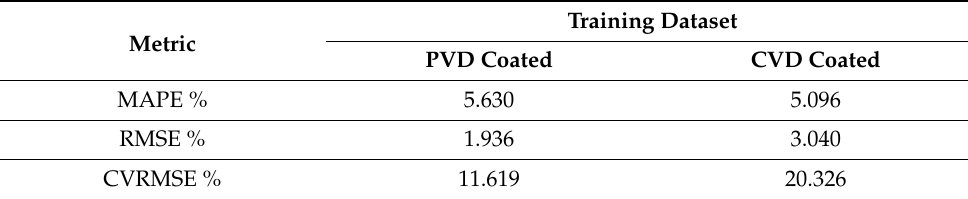
Table 3. Statistical performance metrics of the SVM model with Bayesian optimization for the training